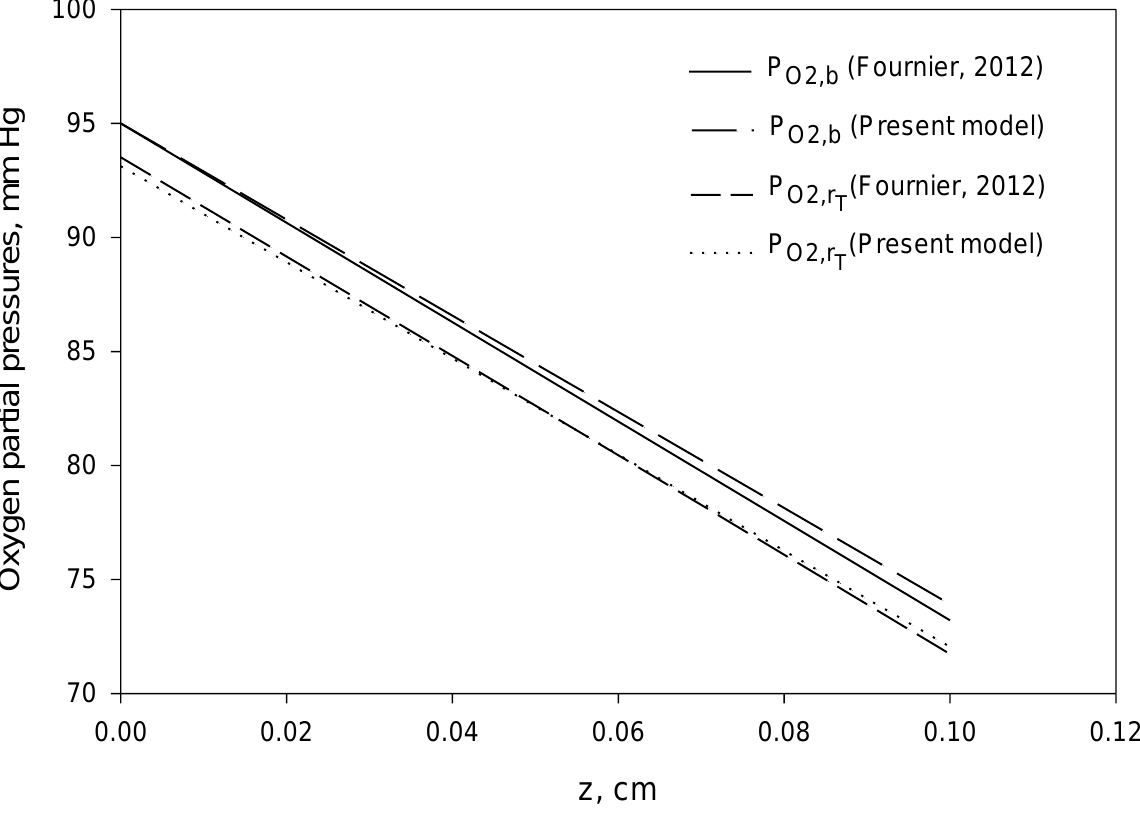
Figure 2. Profiles for dissolved oxygen profiles in blood and at the Krogh tissue cylinder radius.